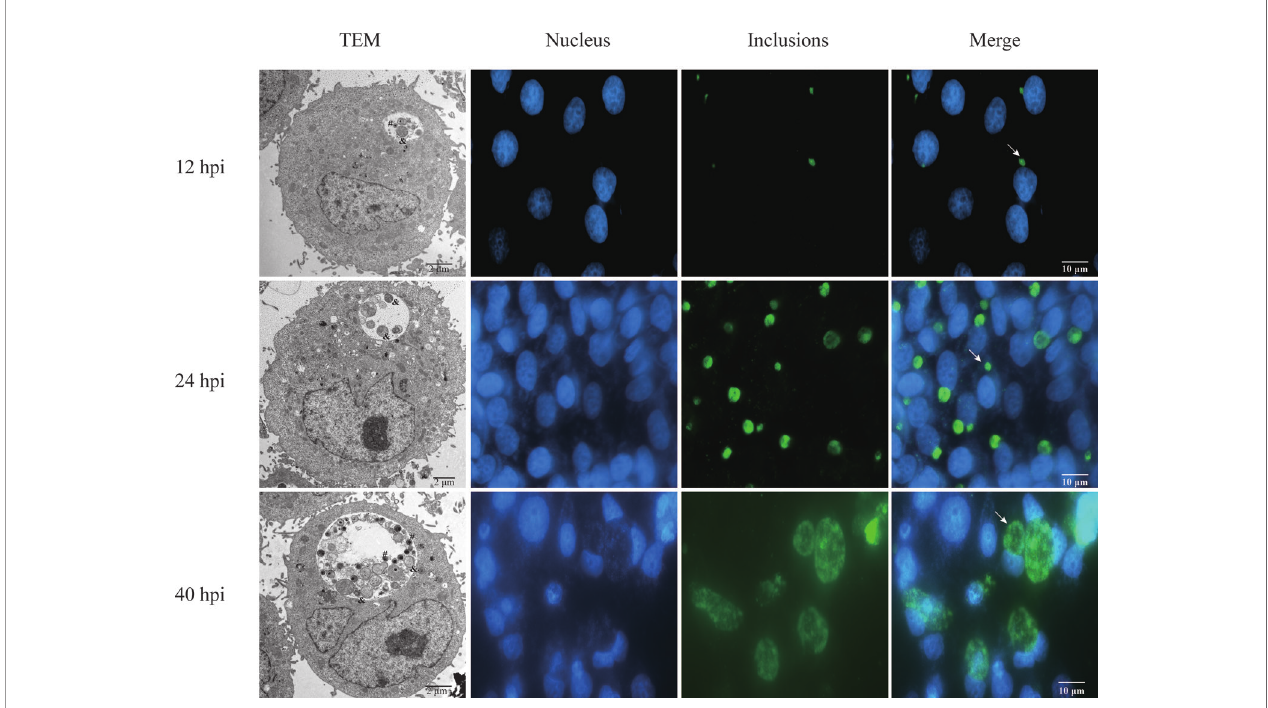
FIGURE 2 | Acute infection of Ct. HeLa cells were infected with Ct at 12, 24, and 40 hpi. The left panel exhibited the inclusions in cells that were mixed and detected by TEM. The symbol of # presents EBs, and & indicates RBs. Other panels exhibited that the infected cells were fi xed at different time points. DNA (blue) was stained by Hoechst 33258, and inclusions (green) were stained by Cy2. Arrows denote